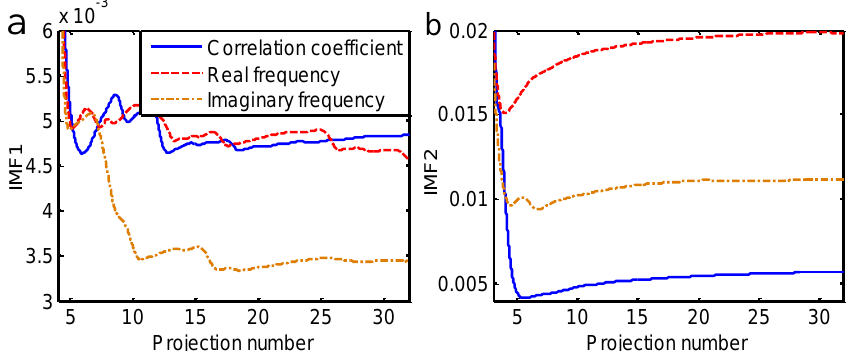
Figure 7. ( a ) The correlation coefficient of each true IMF; ( b ) the frequency of each true IMF; ( c ) calculation time for the BEMD procedure.